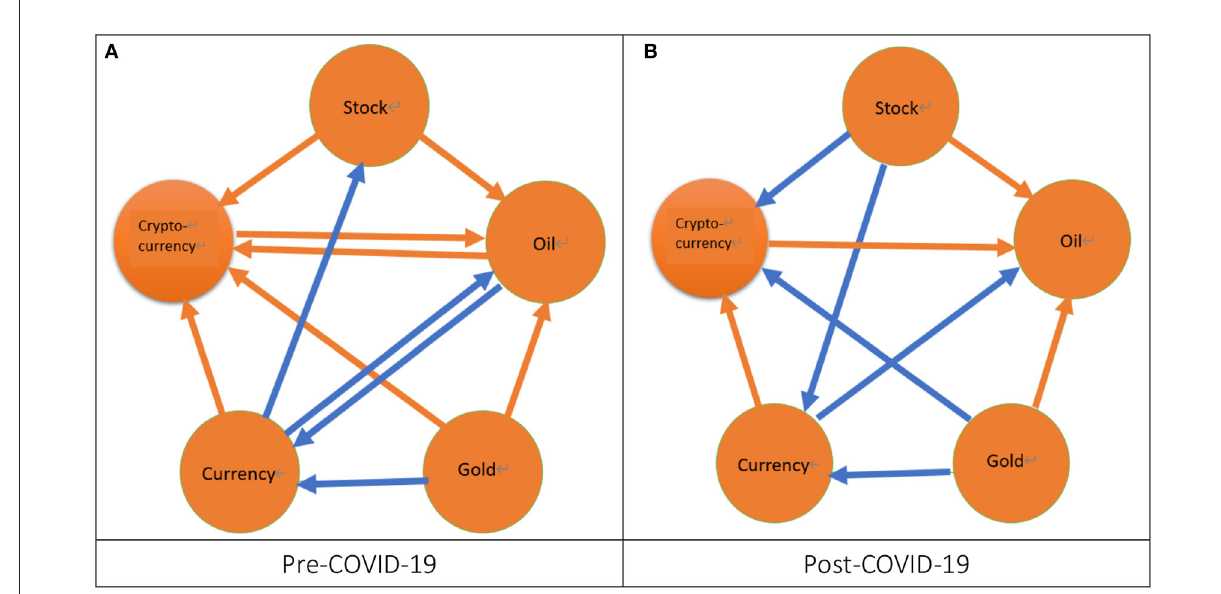
FIGURE3 The network of volatility spillover. 1. The orange arrow from a specific node to another node denotes a significant volatility spillover from a market represented by this specific node to another market represented by another node. 2. The blue arrow from a specific node to another node represents a slightly significant volatility spillover from a market represented by this specific node to another market represented by another node. (A) Pre-COVID-19 and (B) Post-COVID-19.